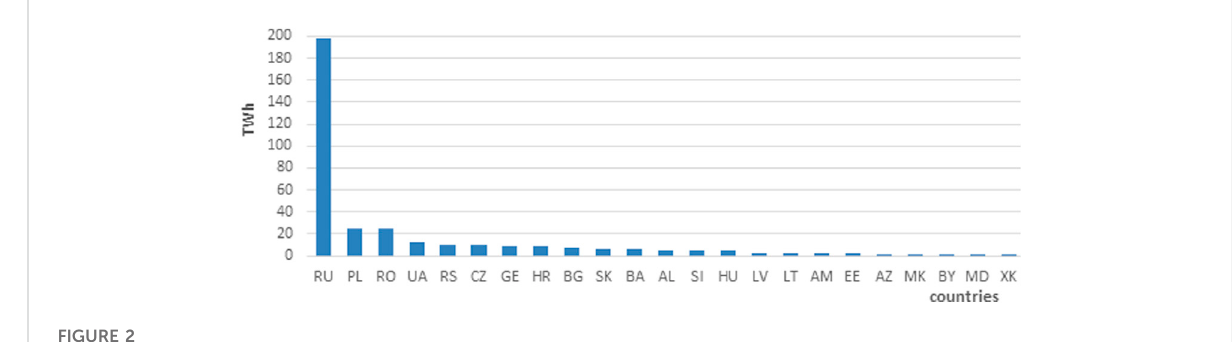
FIGURE 2 Production of energy from renewable sources in countries of Central and Eastern Europe in